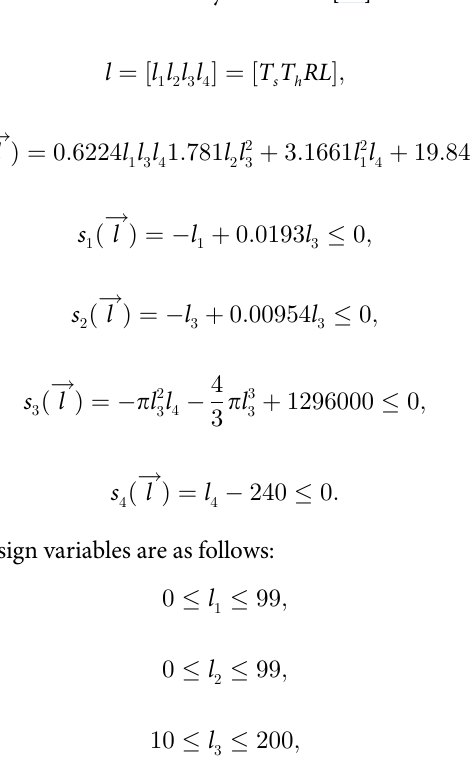
to find best results early in the iteration process, they searched the space for the optimal solu- tion and were able to converge towards the best result and remain stable until the end of the optimization iterations. The dissimilarities in behavior of the curve at the different iteration phases show sensitivity to the initialization scheme used by the initial candidate solution. Moreover, we see the efficient performance of nAOA, AOA, GSA, GWO, SCA, and SSA because their curves lie together at the bottom of the figure. By contrast we note the sub-opti- mal performance of PSO, BBO, GA, and DE, indicated by curves lie together at the top of the figure because they show large cost function values. Fig 10. The four decision variables are defined as follows: x 1 is the thickness of the pressure vessel T , x 2 is the thickness of the head T , x 3 stands for the inner radius of the vessel R , and s h x 4 is the length of the vessel barring head L .